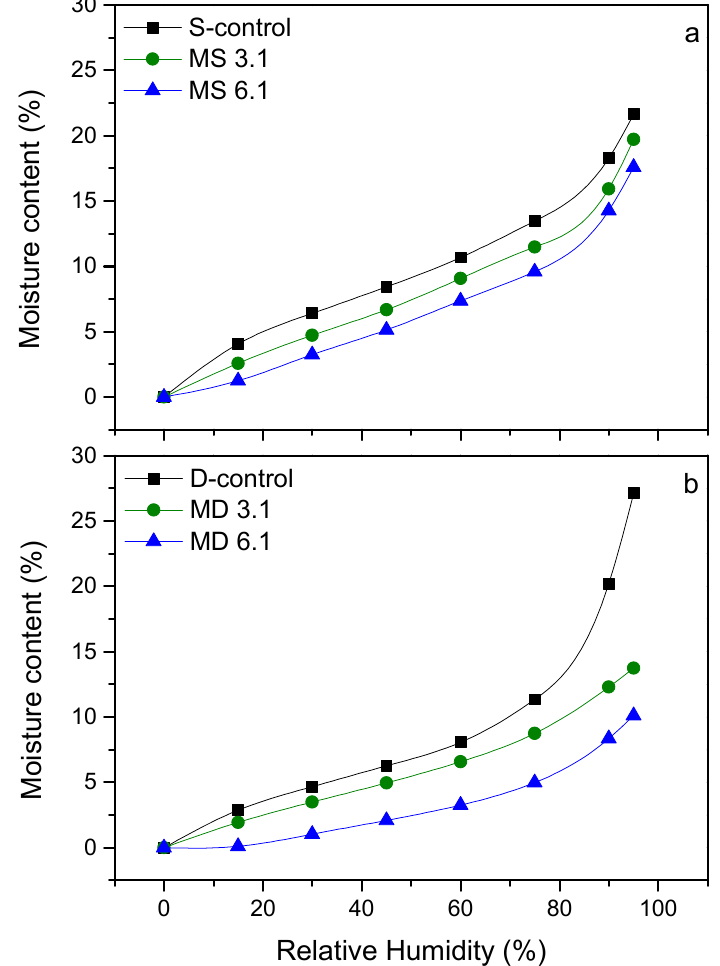
Figure 5. Moisture content (MC) of S-control, MS 3.1 and MS 6.1 ( a ) and D-control, MD 3.1 and MD 6.1 ( b ) for whole range of